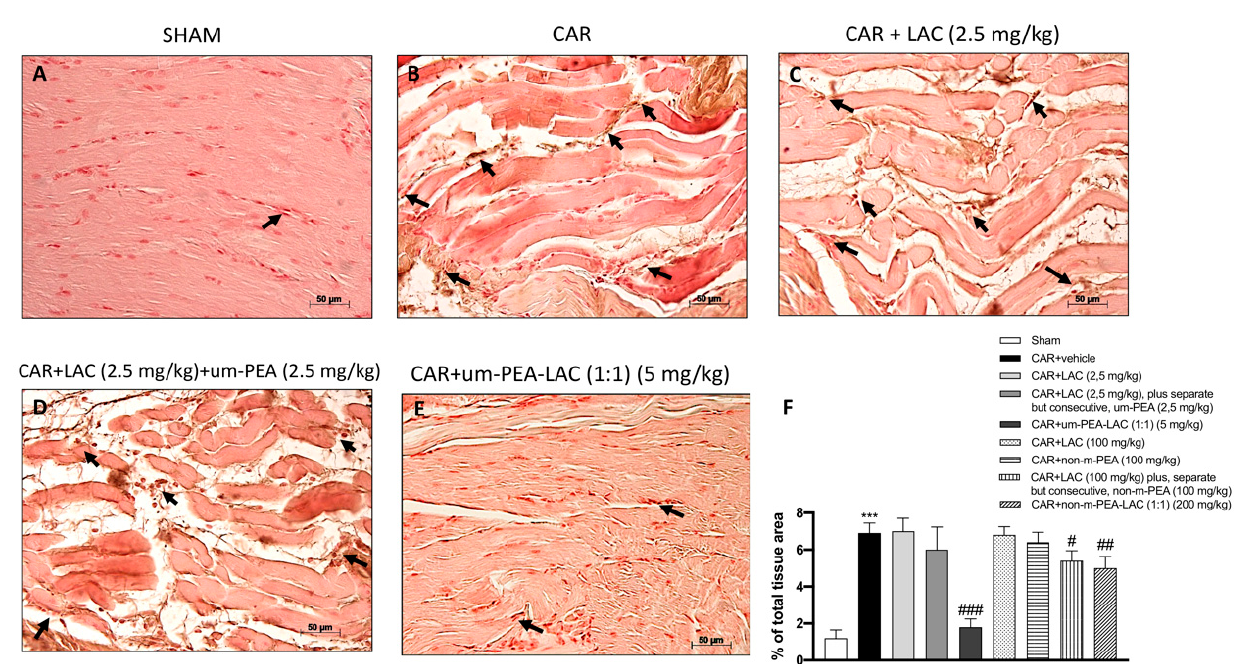
Figure 4. Efficacy of um-PEA and LAC treatment on ICAM-1 expression. Paw tissues collected from CAR treated-animals showed positive immunostaining for ICAM-1 ( B , F ), compared to the sham group ( A , F ). CAR + LAC (100 mg/kg) plus, separate but consecutive, non-m-PEA (100 mg/kg) and CAR + non-m-PEA and LAC groups (1:1) (200 mg/kg) slightly reduced positive immunostaining (data not shown); while um-PEA and LAC (5 mg/kg) administration strongly reduced this expression ( E , F ). Other administrations, individually or mixed, did not show a significant down-regulation of ICAM-1 expression ( C , D , F, and data not shown). Black arrows indicate the positive staining for ICAM-1. Data are representative of at least three independent experiments. Values are means ± SEM. One-Way ANOVA test. *** p < 0.001 vs. sham; # p < 0.05 vs. CAR; ## p < 0.01 vs. CAR; ### p < 0.001 vs. CAR.